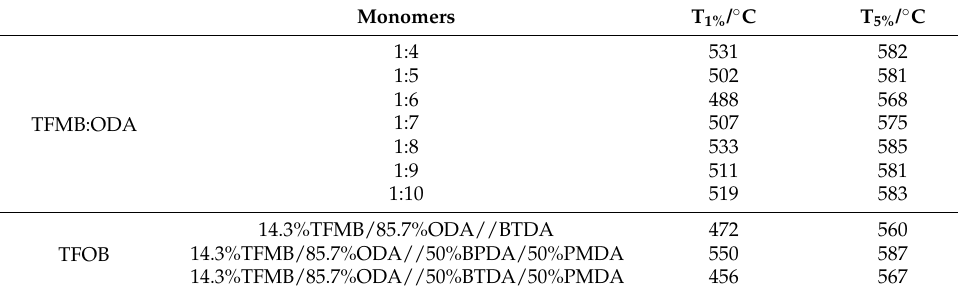
Table 3. Thermal properties of PI films in group TFOP and group TFOB.